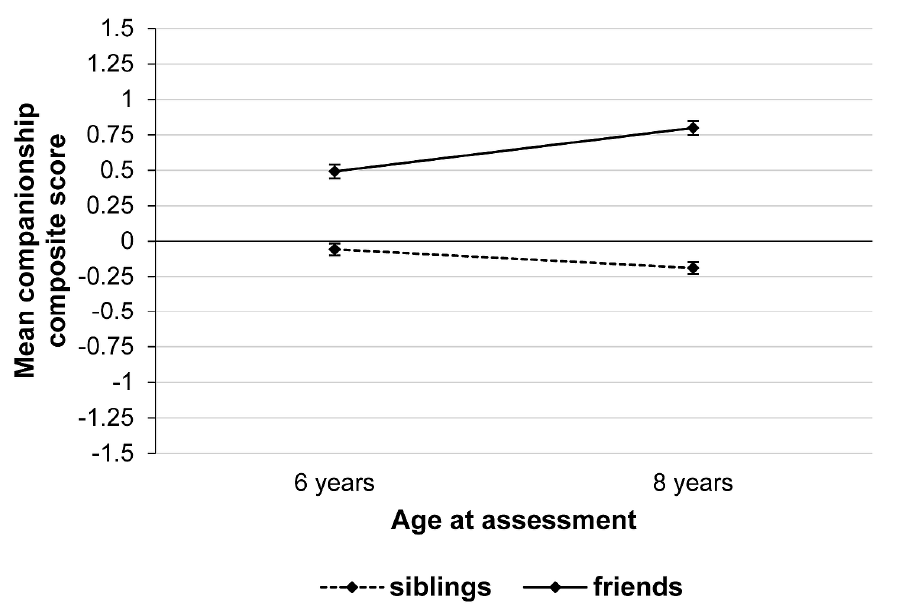
Figure 3. Mean companionship composite scores for social relationships with siblings and friends at 6 and 8 years ( N = 1110). Error bars represent 95% confidence intervals. Companionship composite scores were obtained by averaging subscales Fun/Fooling Around, Playing, and Prosocial Behavior separately for social relationships with siblings and friends at 6 and 8 years of age. Companionship composite scores ranged from − 2 to +2.